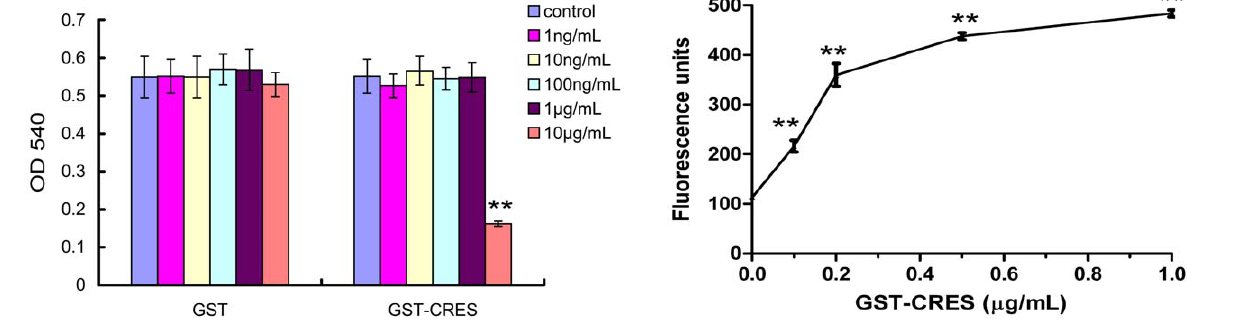
Figure 4. Determination of the epididymal epithelial cells viability treated with CRES using MTT assay. ** p , 0.01.